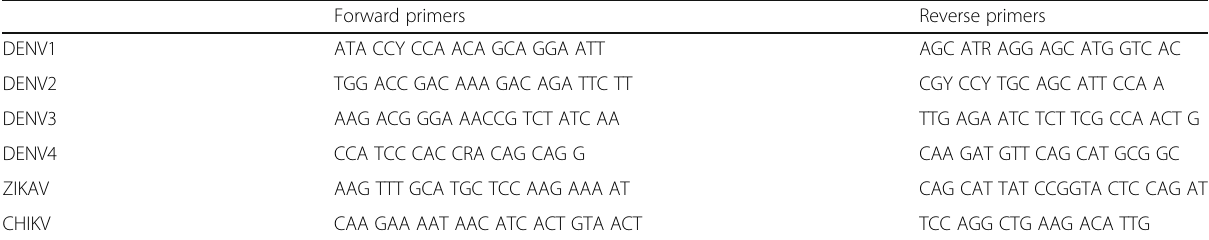
Table 1 The primers used in the qPCR screening of the arbo-viruses Forward